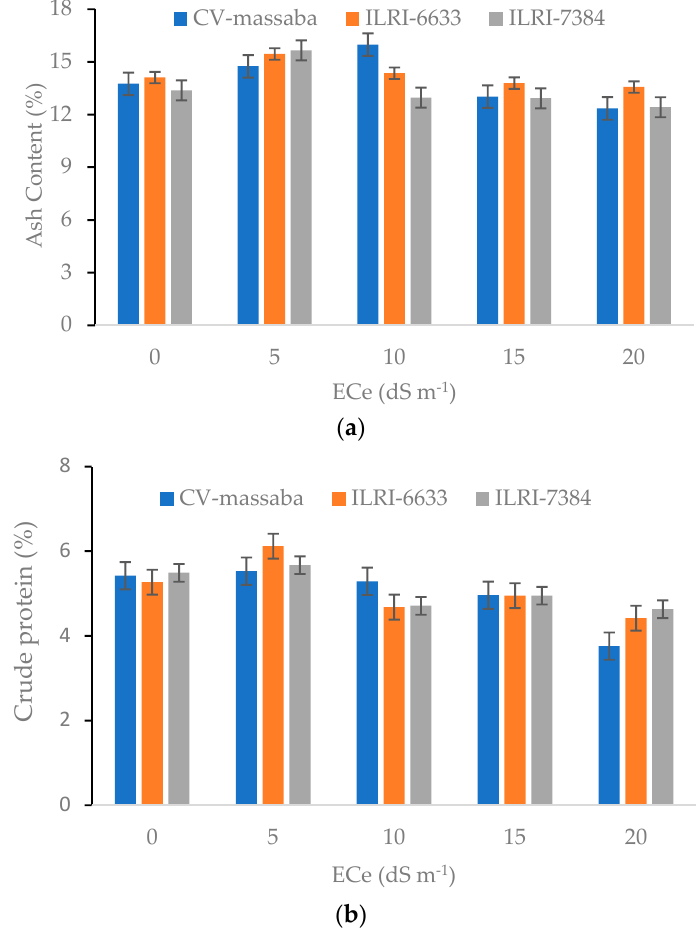
Figure 5. Effect of different salinity levels on ( a ) Ash content (LSD = 1.71; CV = 9.75) and ( b ) Crude protein (LSD = 1.05; CV = 13.65) on three Chloris gayana genotypes.